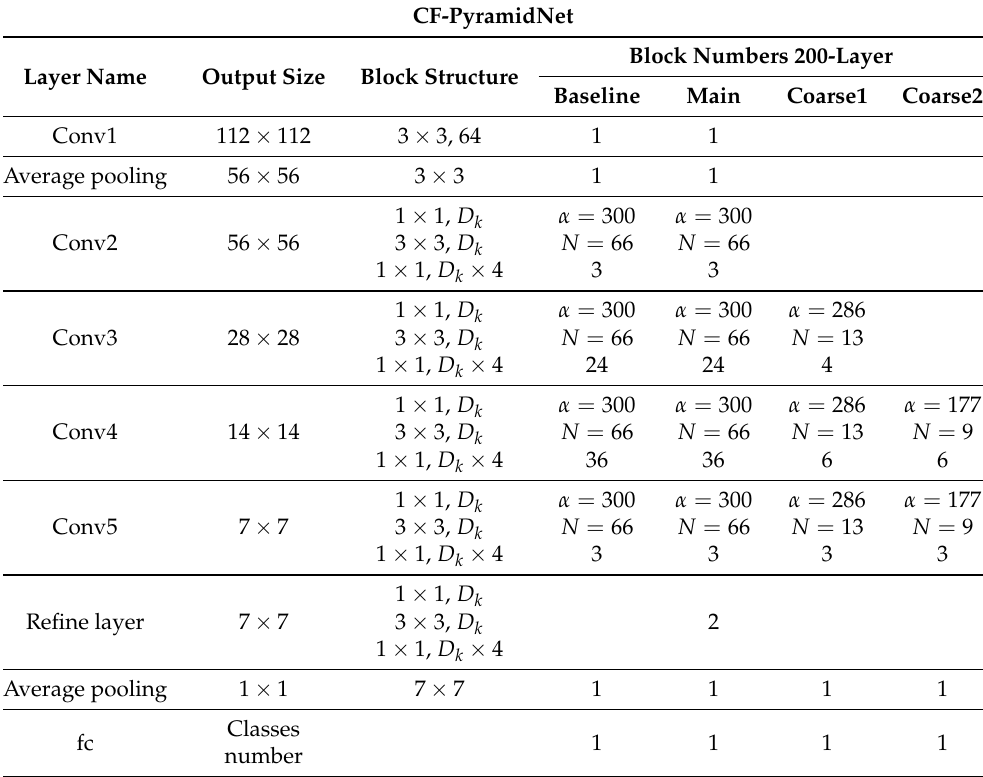
Table 7. Structure of the CF-PyramidNet model for ILSVRC 2012